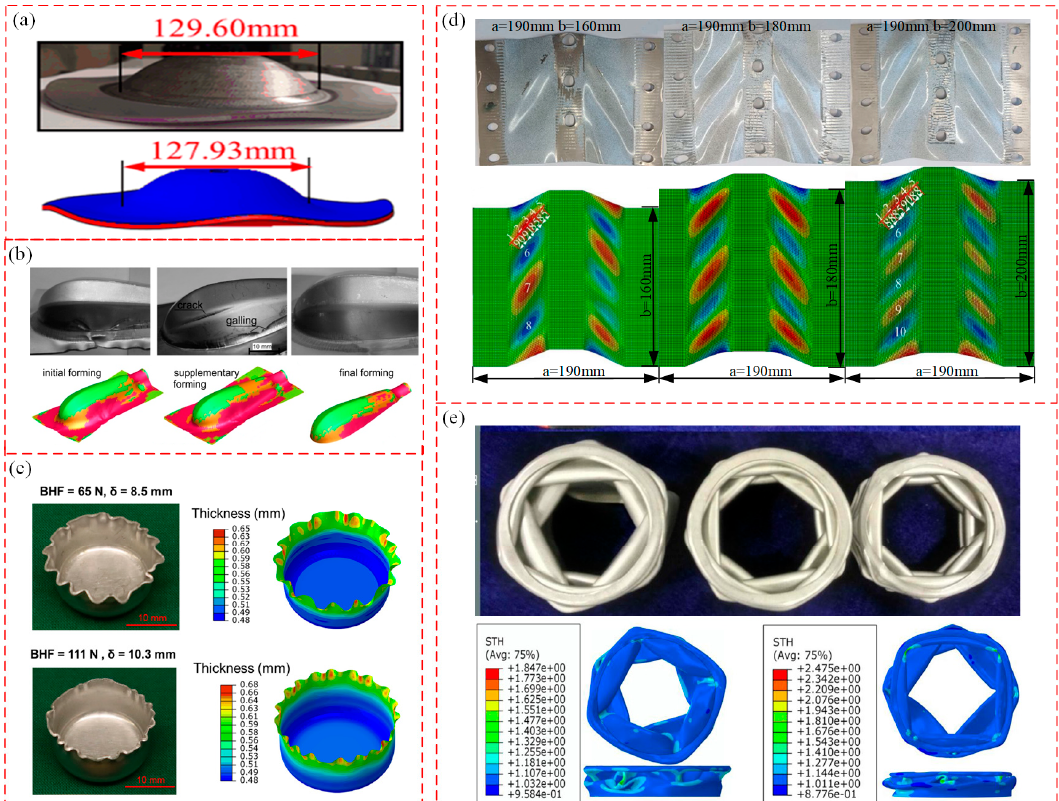
Figure 15. Research results of deformation instability by finite element simulation and experimental methods: ( a ) flange forming of the spinning thin-walled plate [171]; ( b ) stamping forming of a titanium alloy mechanical handle [184]; ( c ) deep drawing of the AA1100 aluminum alloy [185]; ( d ) 304 steel plate shear wrinkling test [187]; ( e ) various buckling modes of tube compression instability [140].